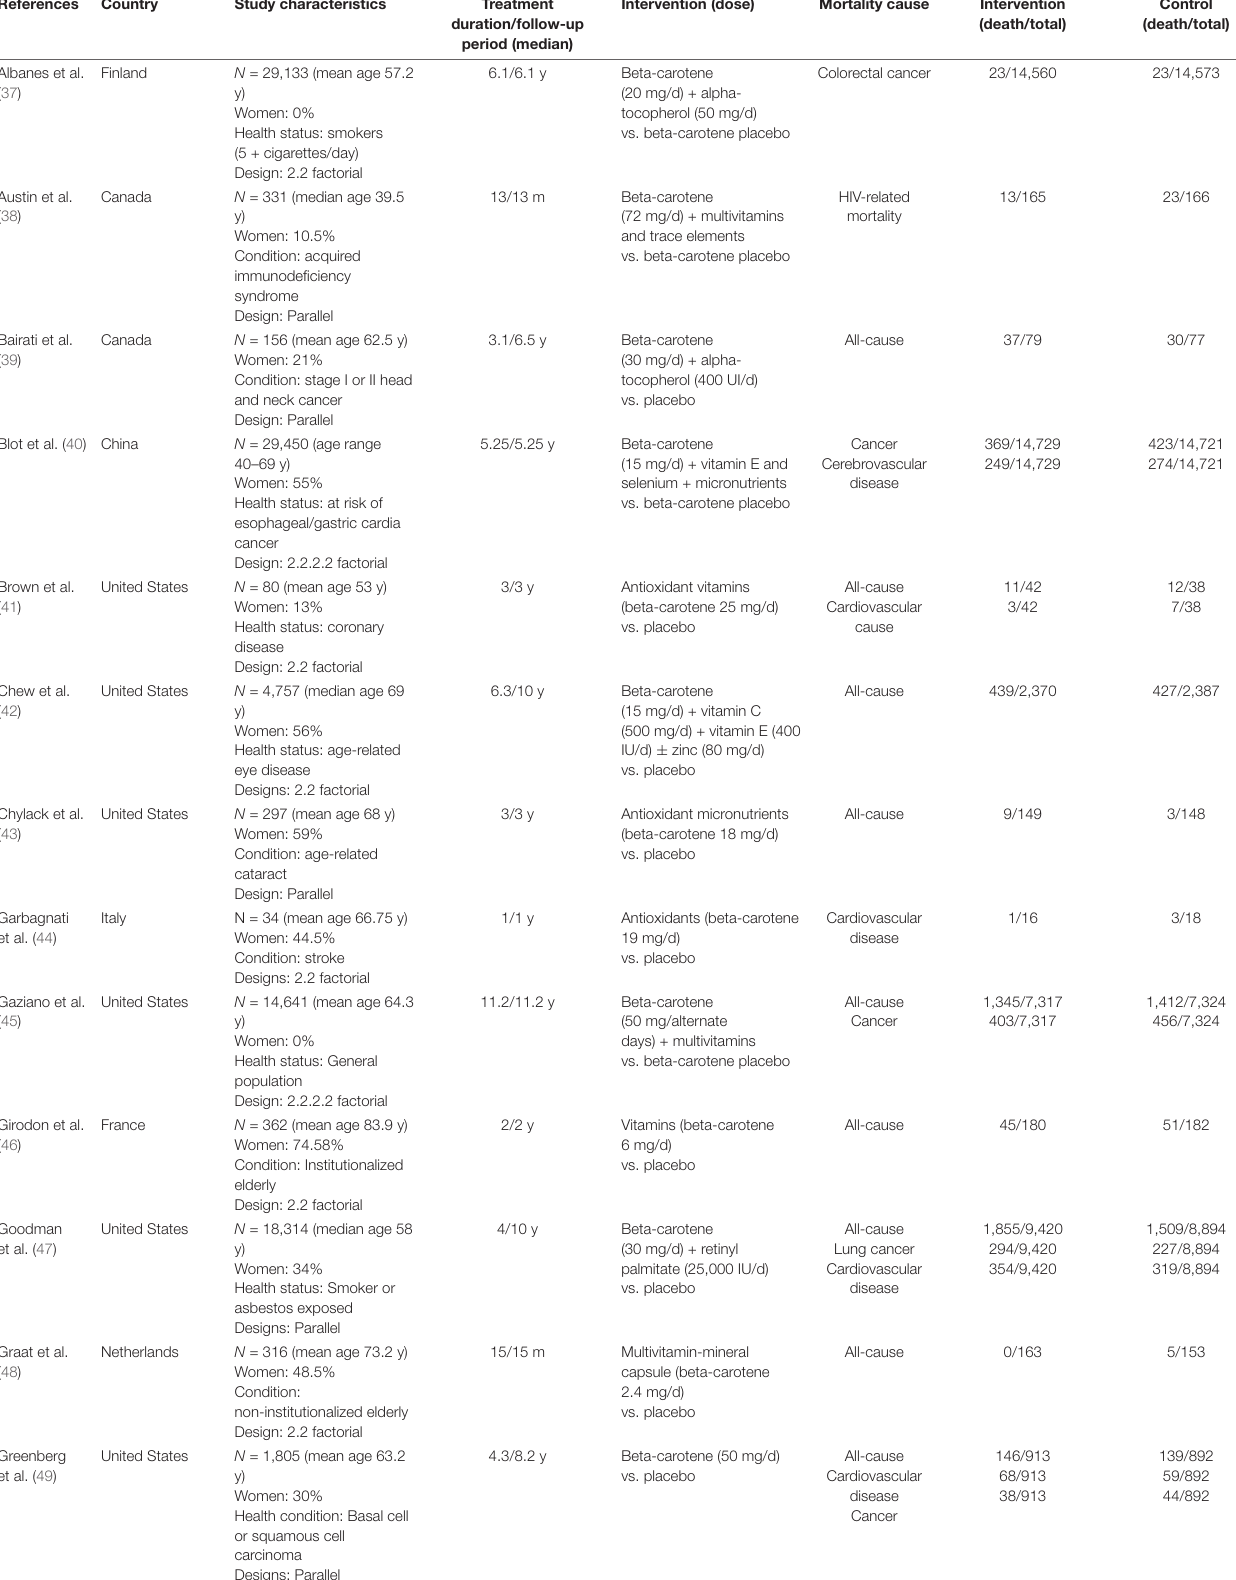
TABLE 2 | Data summary of randomized controlled trials assessing the effects of beta-carotene supplementation on mortality ( n = 44). References